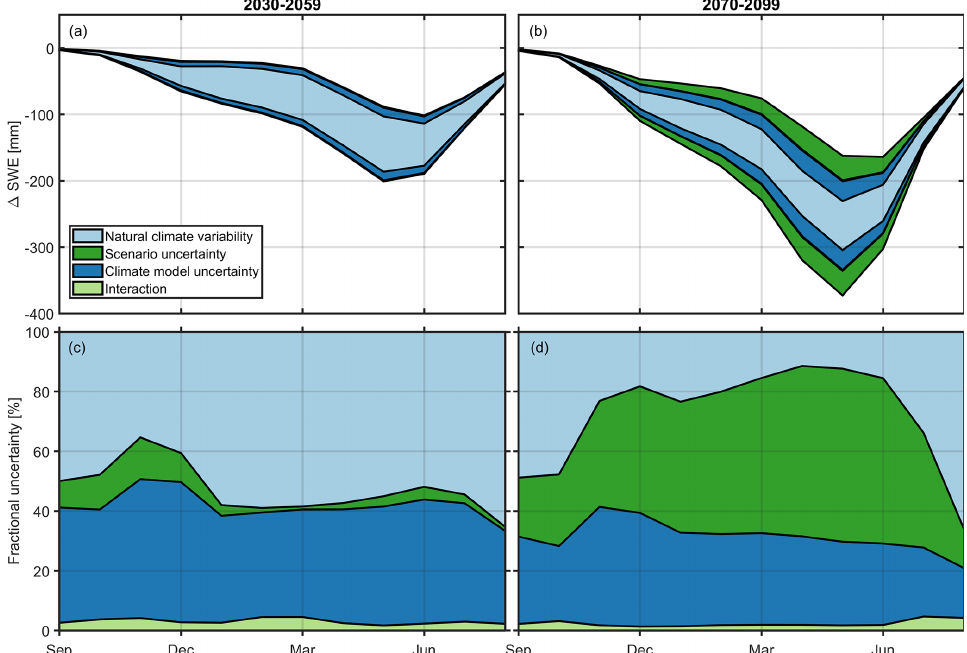
Figure 11. Climate change signal of monthly mean SWE and illustration of the sources of uncertainty in the SWE projections (90% quantile ranges) of the (a) middle and (b) end of the century. The fractional contribution of individual sources to the total uncertainty in the (c) middle and (d) end of the century.